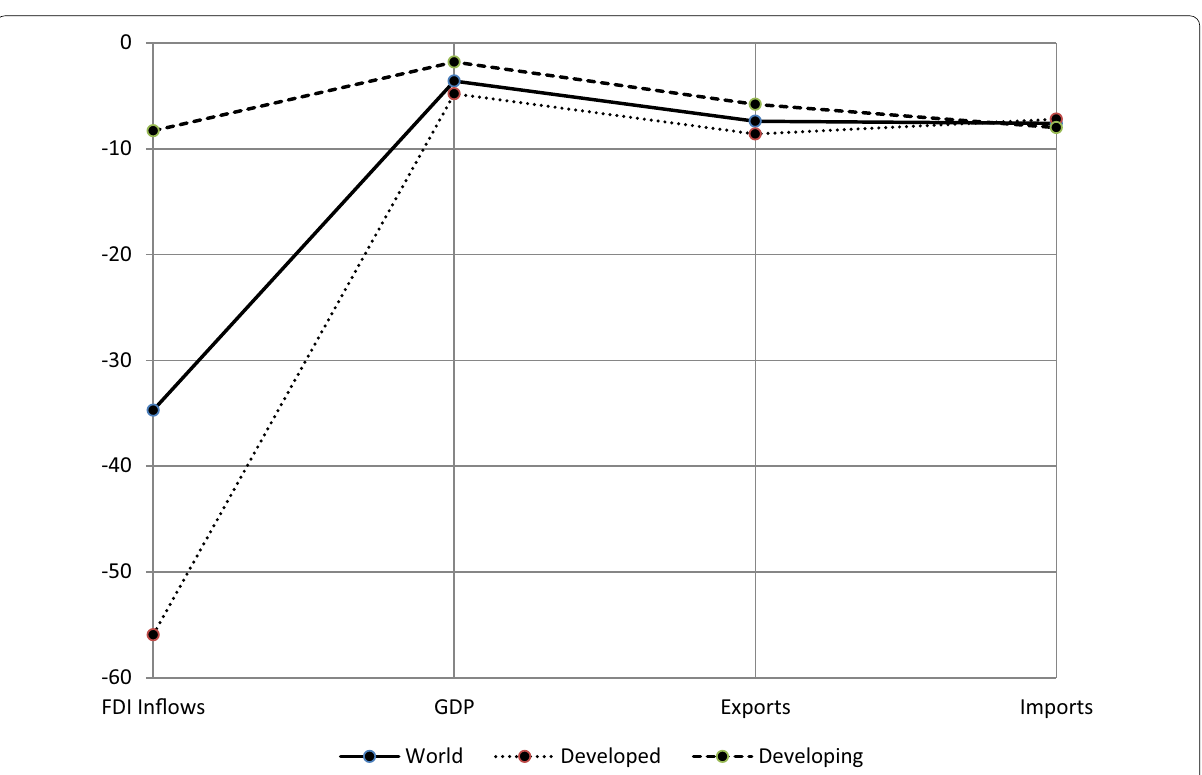
Fig. 4 A comparison of the growth rates of FDI inflows, GDP, and trade